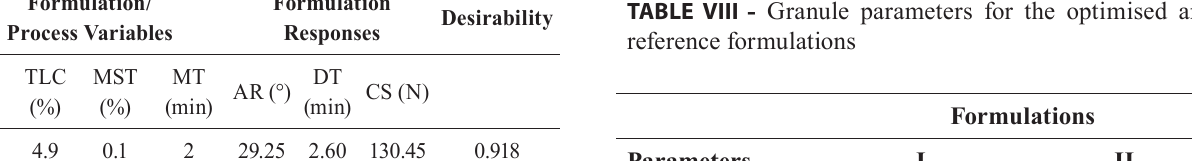
TABLE VI - Formulation/Process variables and associated responses Formulation/